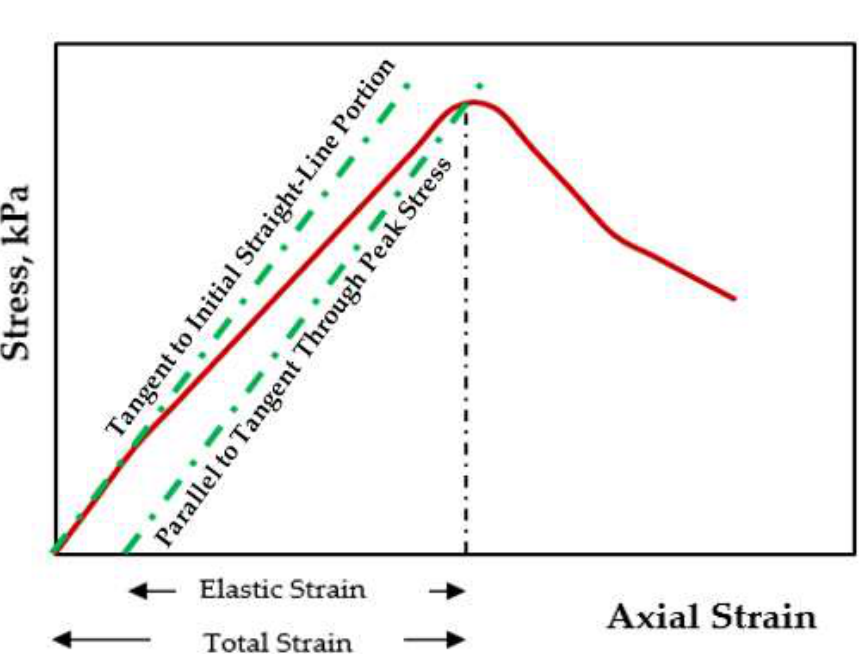
Figure 4. Computation of the brittleness index from a stress-strain curve.